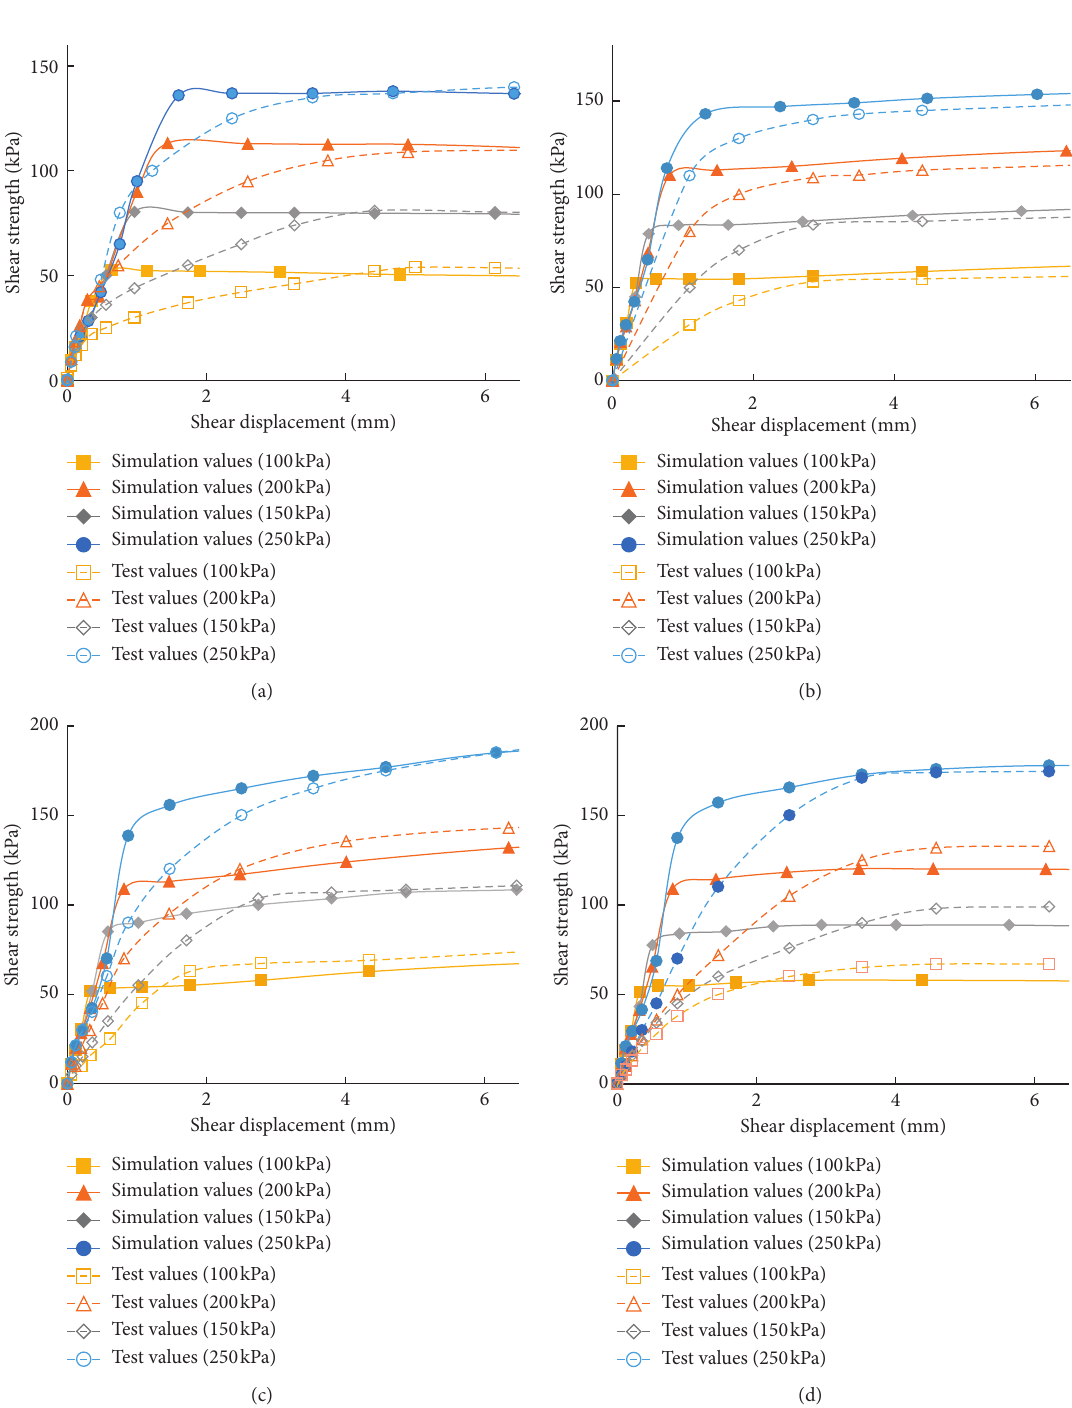
Figure 8: Shear stress-displacement curves of root-soil composites with different root arrangement: (a) ordinary soil; (b) 90 ° +90 ° ; (c) 90 ° + 45 ° ; (d) 45 ° +45 °